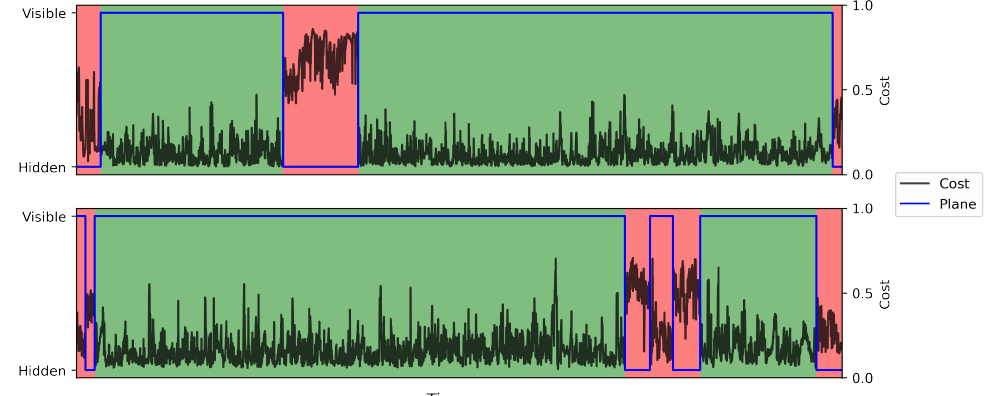
Figure 5. Two example HSTW alignments on the music task. Green and red regions indicate ground truth matching and non-matching regions, respectively. The blue line shows the hidden/visible plane of the optimal path, and the black line shows corresponding costs in the pairwise cost